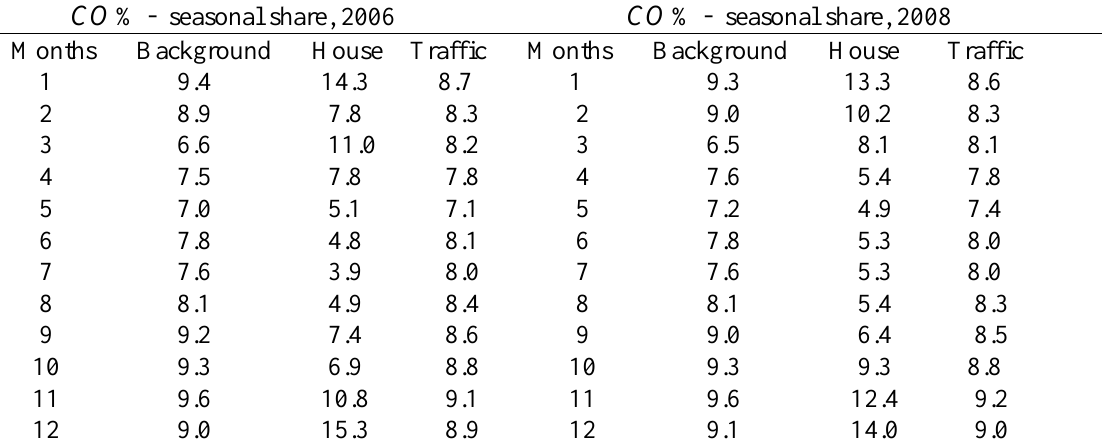
Table 9. C O monthly distribution share by economic activities in the GTA C O % - seasonal share,